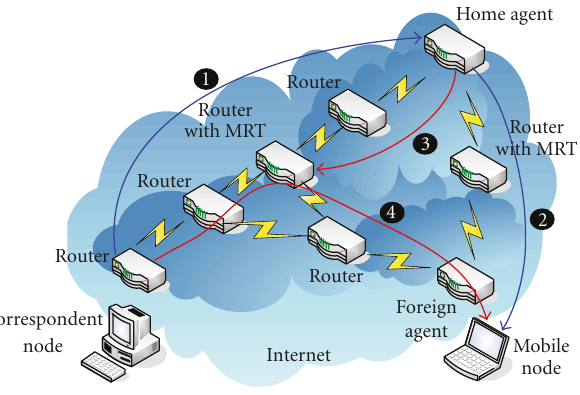
Figure 1: Illustration of tra ffi c flow in the MRT